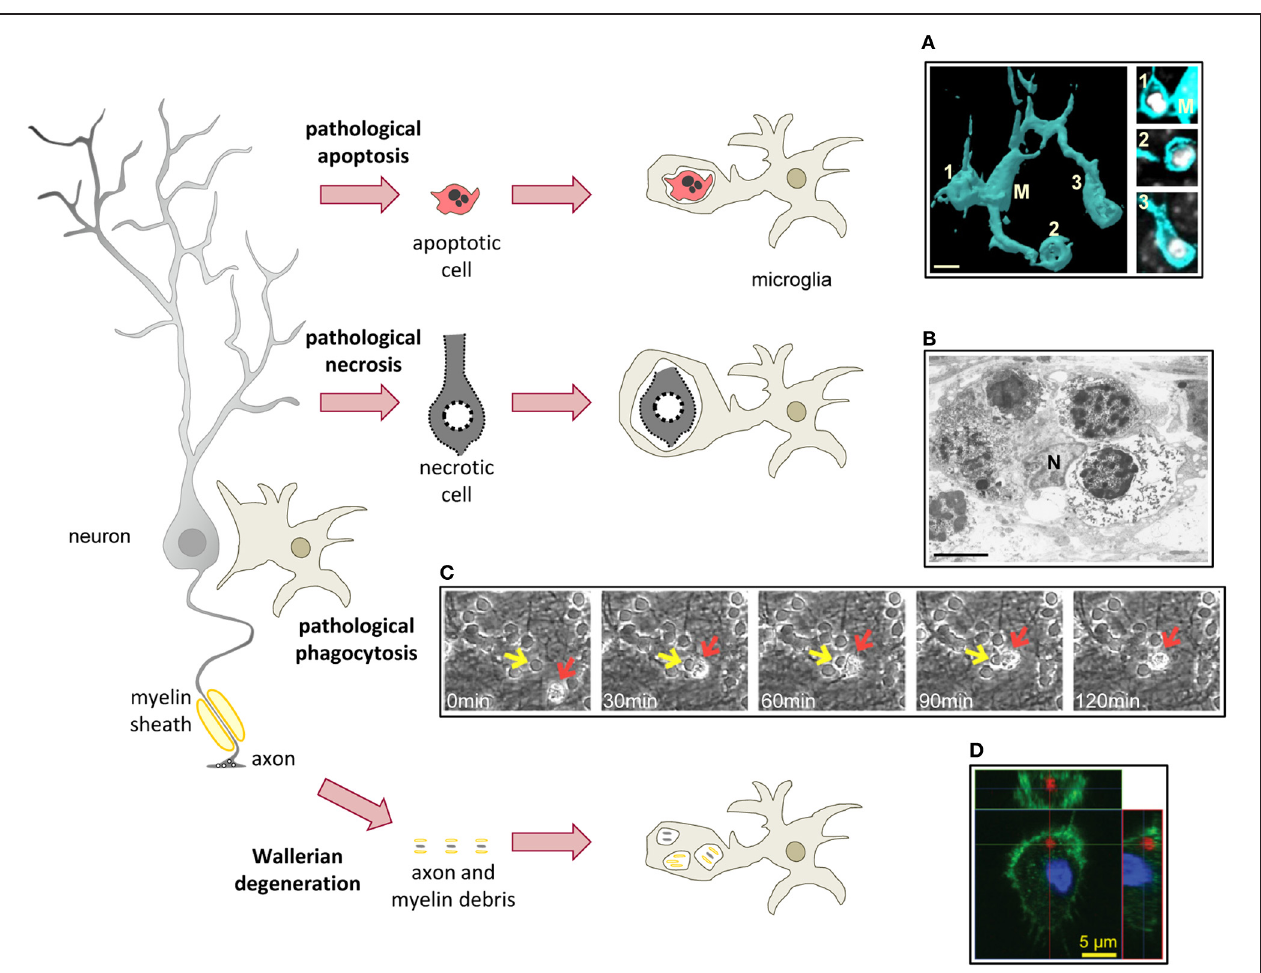
FIGURE 4 | Microglial phagocytosis in disease. In pathological conditions microglia is challenged and usually assumes a hypertrophic morphology. Challenged microglia phagocytose apoptotic and necrotic cells (A,B) . In some inflammatory conditions, microglial phagocytosis can kill healthy neurons (C) . Microglia also phagocytose axonal and myelin debris resulting from Wallerian degeneration of severed axons (D) . (A) Surface-rendered fms-EGFP microglia (M; cyan) from the adult hippocampus phagocytosing three apoptotic/pycnotic cells (labeled with DAPI, white), in a mouse systemically challenged with bacterial lipopolysaccharides (5mg/kg). (B) Electron microscopy microphotograph of embryonic (E20) microglia (N, microglial nucleus) from the rat cingulate cortex following maternal hypoxia (1 day) containing four engulfed dead cells. In the developing brain, hypoxia induces